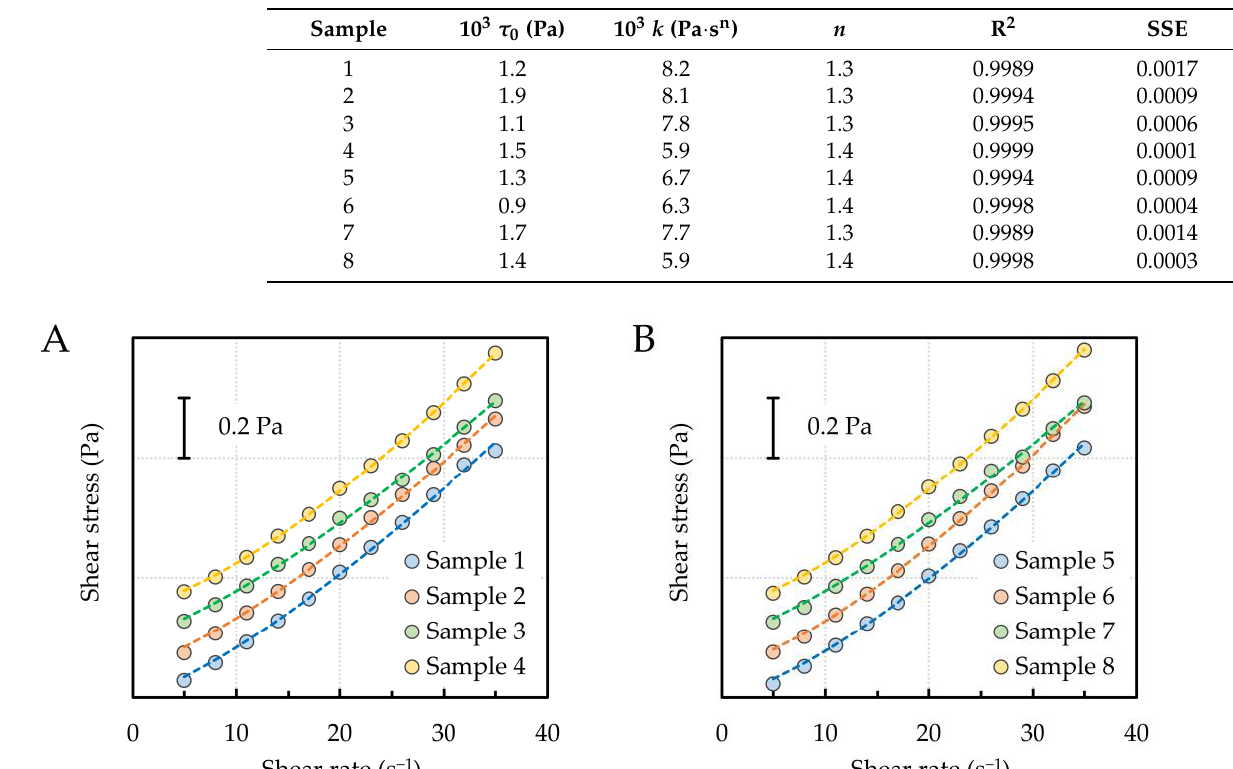
Table 3. Optimized parameters of the Herschel–Bulkley model.